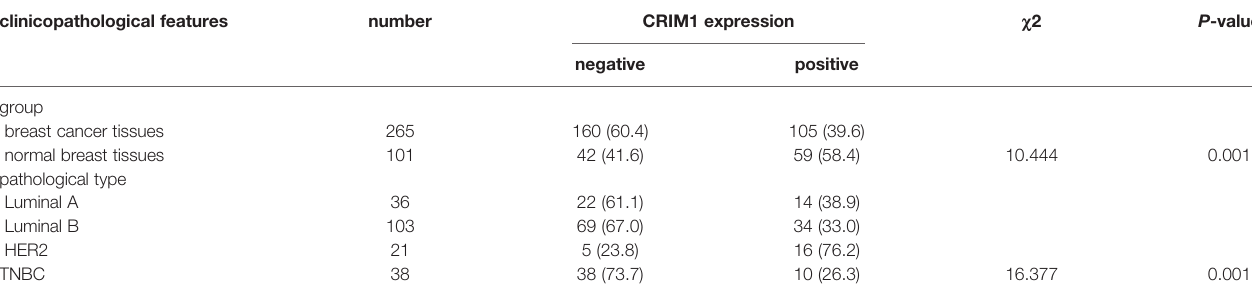
TABLE 2 | CRIM1 expression in different subtypes of breast cancer and normal tissues using Immunohistochemistry [n(%)]. clinicopathological features